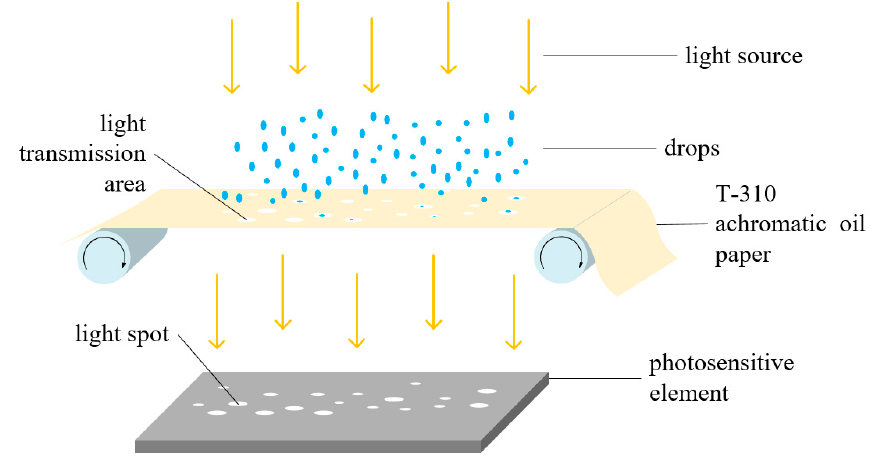
Figure 3. The principle of the generation of droplet spot.